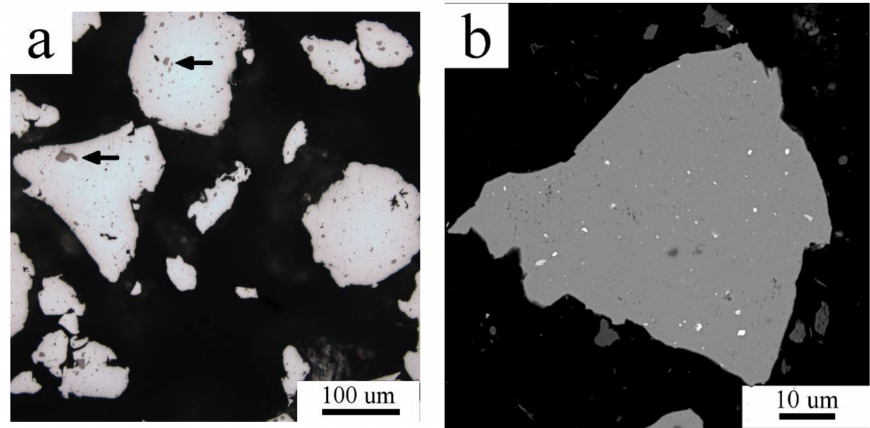
Figure 2. The microstructure of the Al7075_M powder particles: ( a ) morphology (LM); ( b ) internal microstructure in BSE contrast, scanning electron microscopy